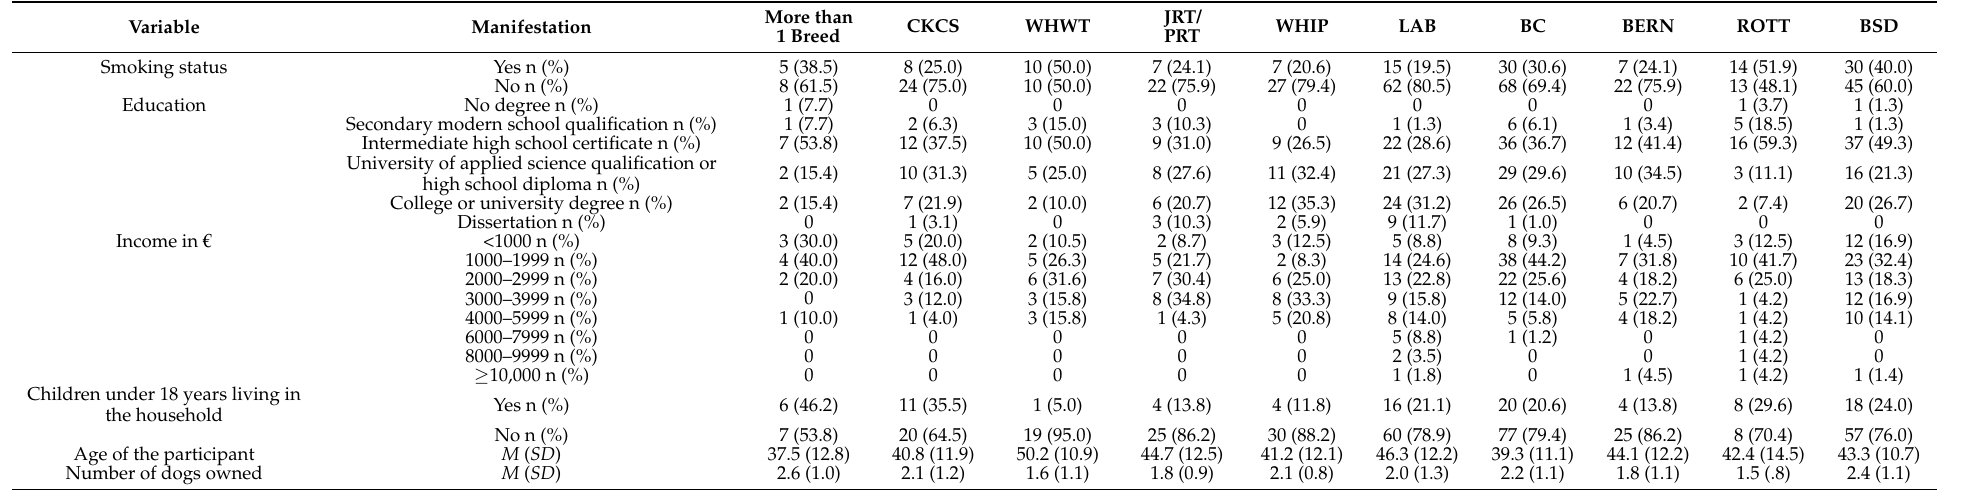
Table 1. Sociodemographics of the participants split by owned breed at